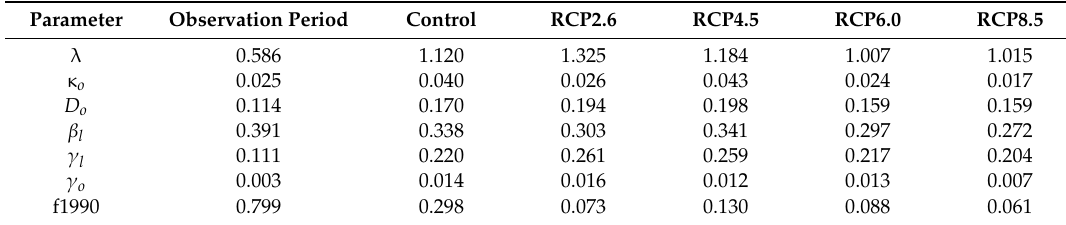
Table 1. Parameters sensitivity of MiCES model (unitless).